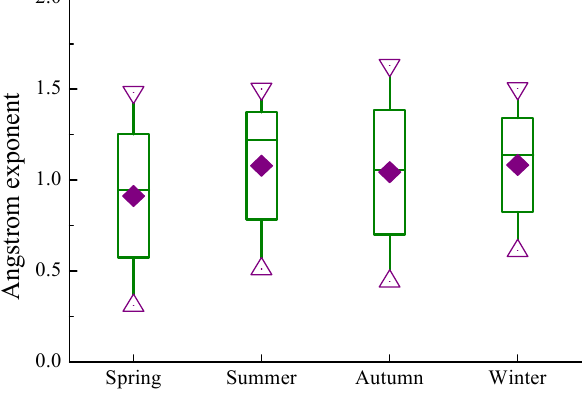
Figure 5. Seasonal statistics of Ångström exponents. The purple diamond represents the mean of the maximum and minimum; the box is 25 and 75 percentiles; the triangles represent the maximum and the minimum, respectively; the short horizontal line represents the seasonal averaged Ångström exponent